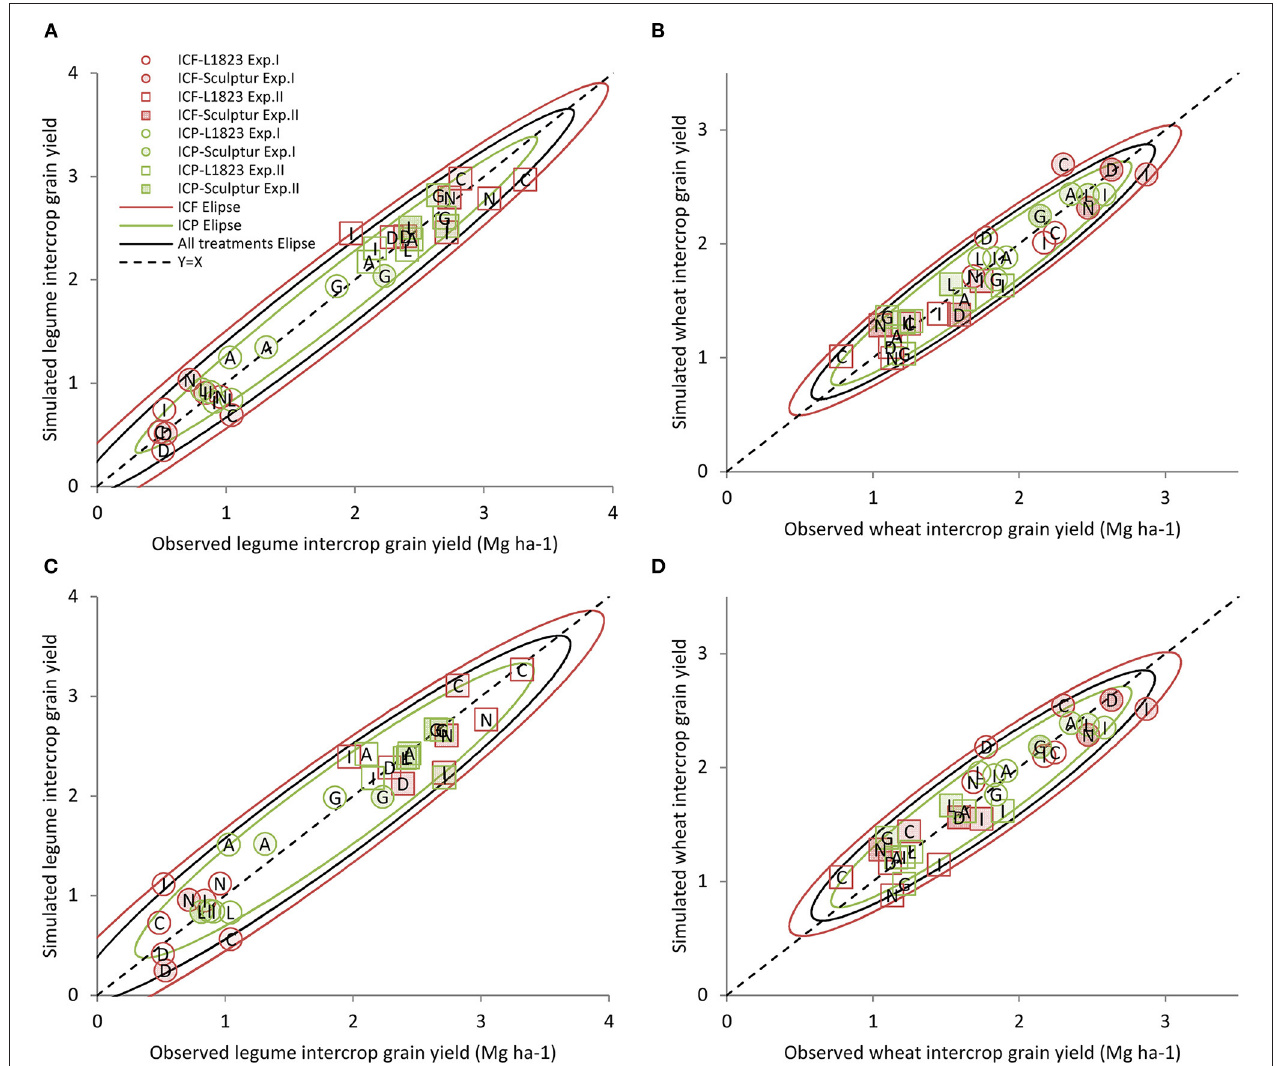
FIGURE 6 | The simulated yield achieved in IC as a function of that observed. Grain yield in IC estimated as a function of that observed considering the complete models with six variables (A, B) or the simplified models with three variables (C, D) for the two legumes (A, C) or the wheat (B, D) both distinguishing the pea and the faba bean. Symbols correspond to ICF (red), ICP (green), Exp.I (circles), Exp.II (squares), L1823 wheat cultivar (open), and Sculptur wheat cultivar (closed). The ellipses represent the prediction interval at p = 0.90 in red for ICF, in green for ICP, and in black for both ICF and ICP. Each point corresponds to the mean of three replicates’